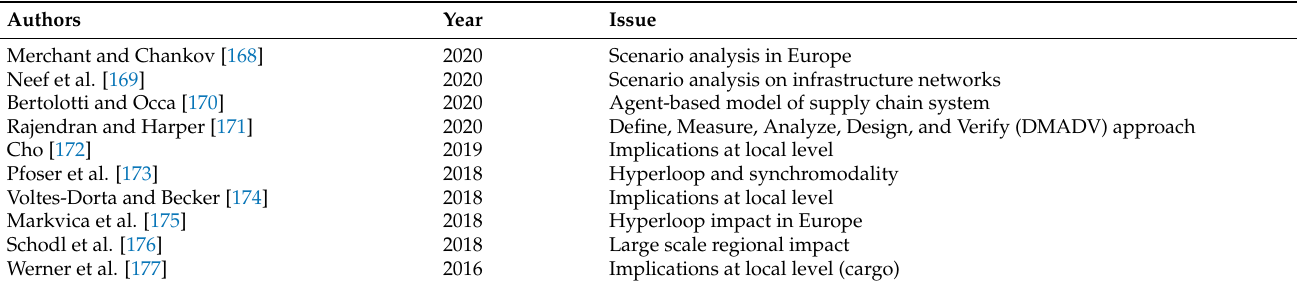
Table 7. Network papers.